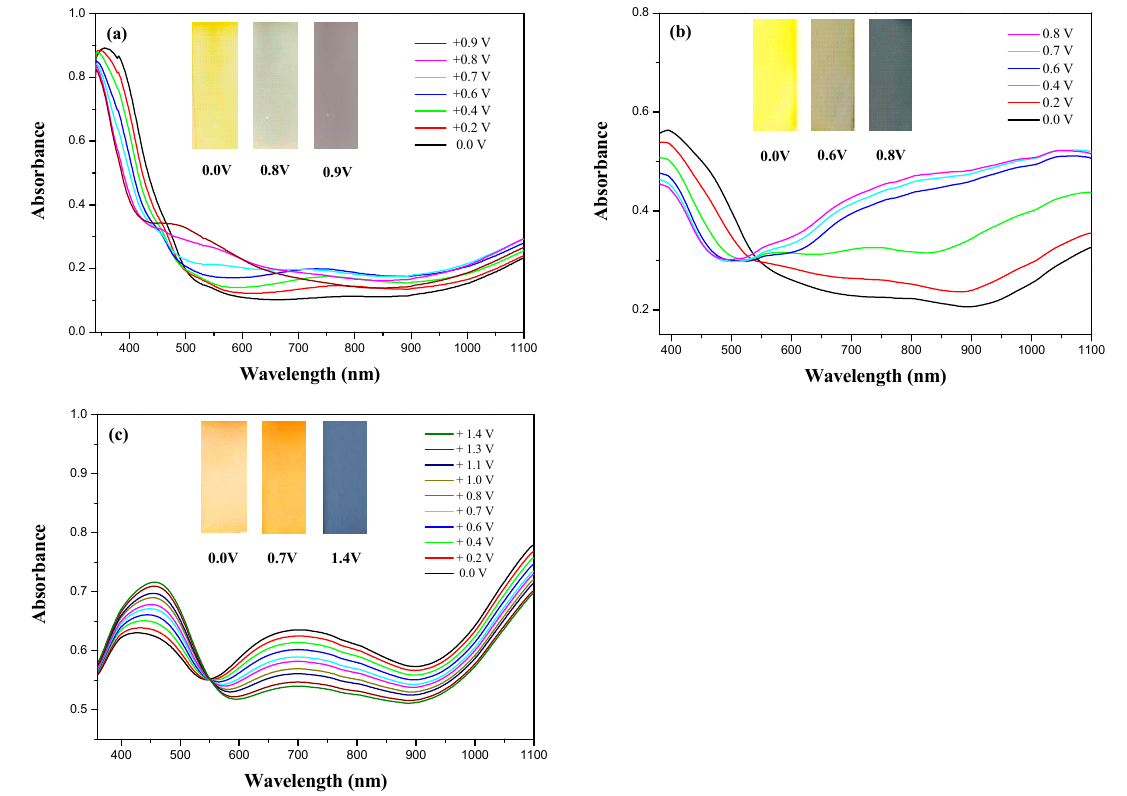
Figure 7. UV-Visible spectra of ( a ) PInc, ( b ) P(Inc- co -bT), and ( c ) PbT on ITO in PC + ACN solution containing 0.2 M LiClO 4 .